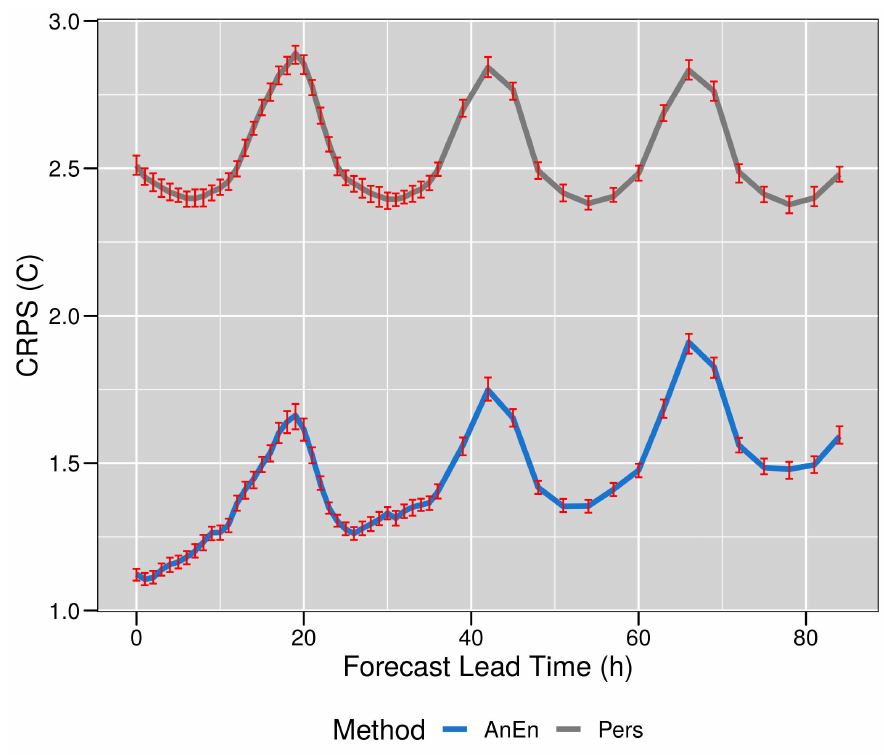
Figure 10. The figure shows the CRPS verification measurement used to evaluate the performance, as a function of FLTs, of the AnEn prediction (blue line) in comparison to the Pers (grey line). The error bars indicate the 95% bootstrap confidence